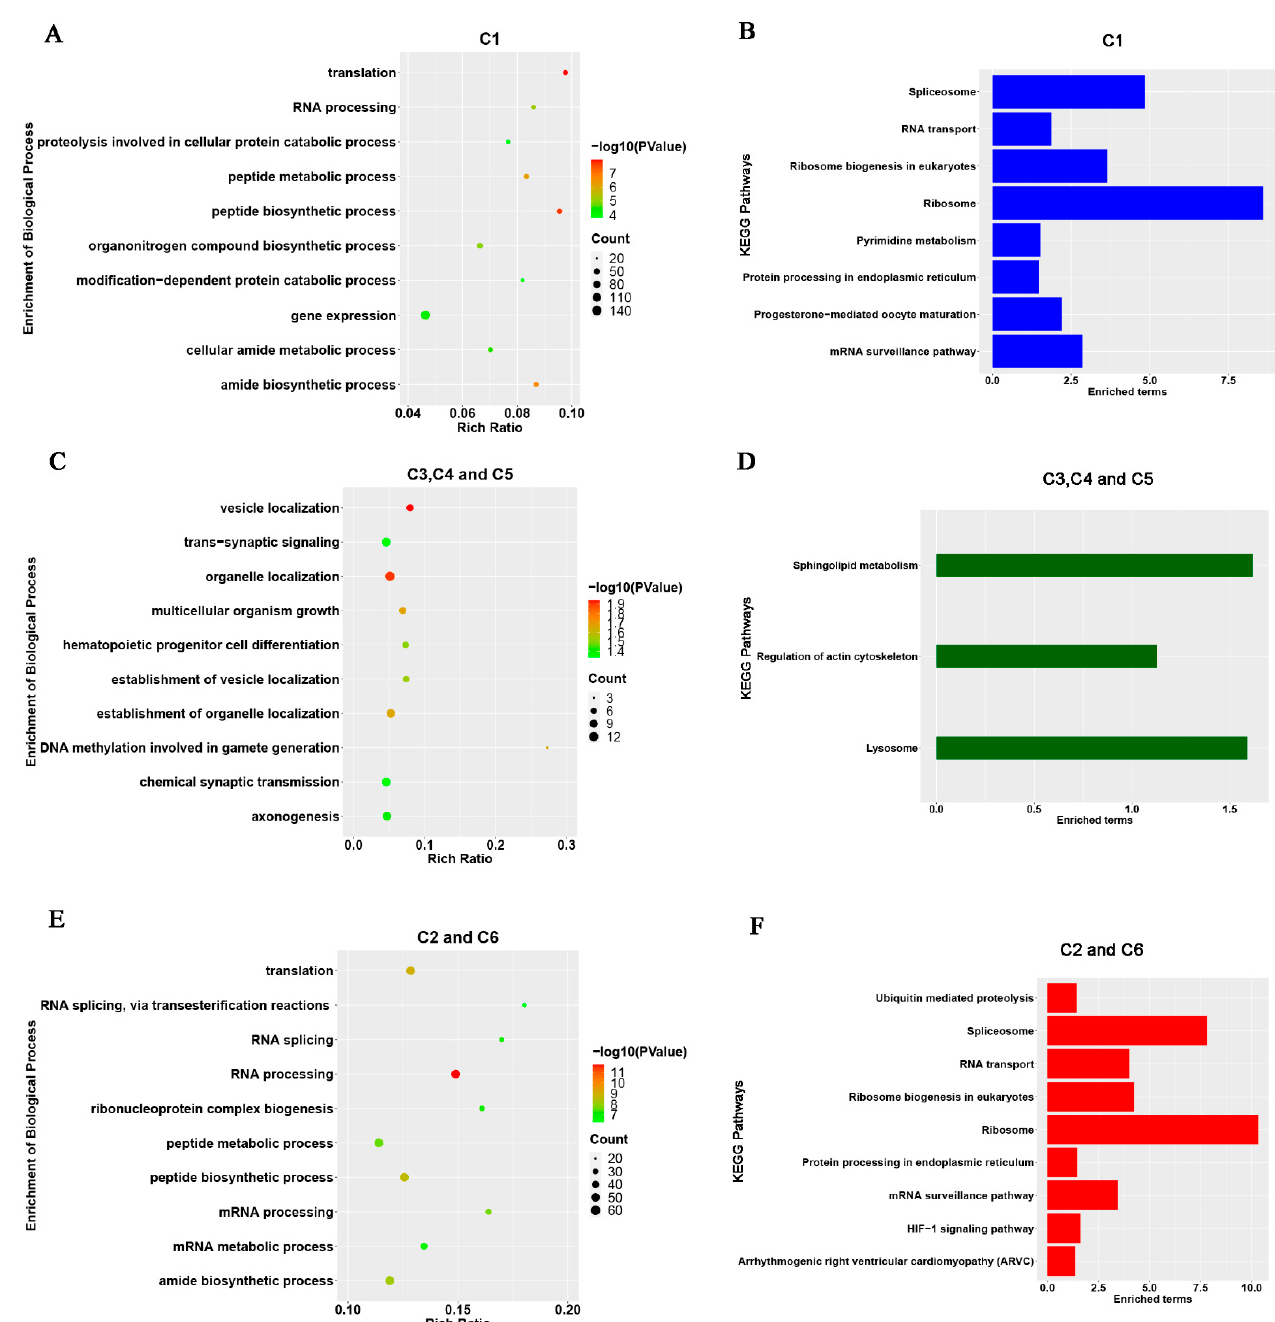
Figure 2. GO and KEGG analyses of DE lncRNA. ( A , C , E ) The top 10 significantly enriched terms of biological process ( p < 0.05). ( B , D , F ). The top 10 significantly enriched KEGG pathways ( p < 0.05). C1–C6: (cluster 1 to cluster 6) identified by k (clustering method from previous analysis). GO (Gene Ontology). KEGG (Kyoto Encyclopedia of Genes and Genomes).